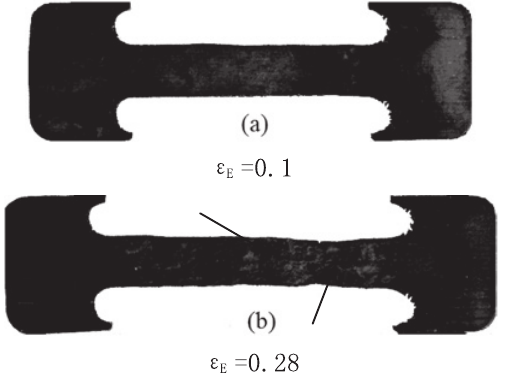
Fig. 5: Surface morphology of the specimen under various strains